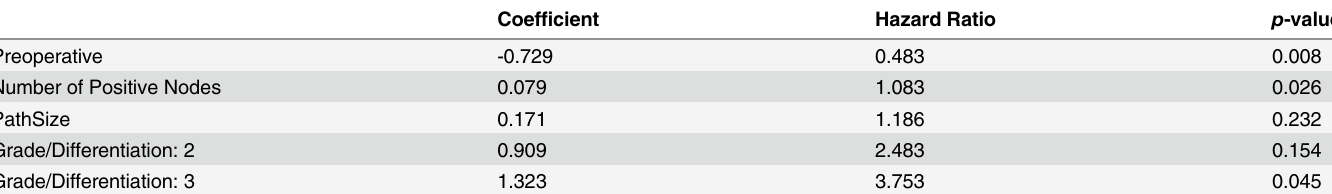
Table 3. Parameter Estimates from Multivariate Cox Regression Model for Overall